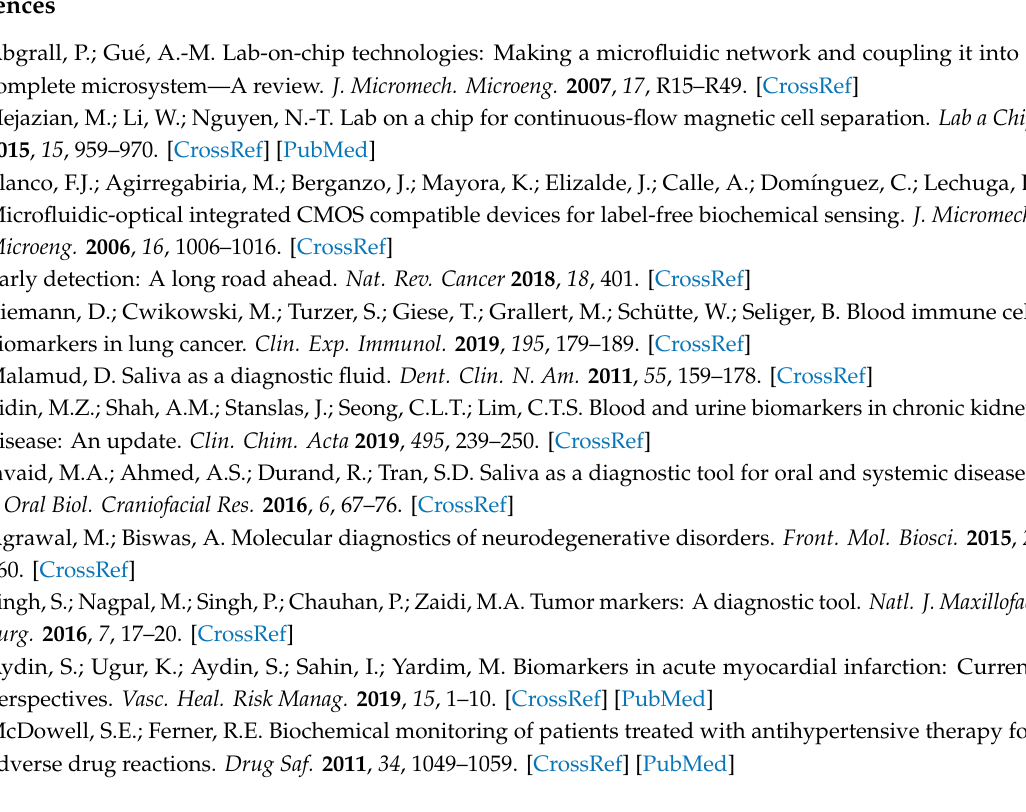
Figure S1: Soft lithography for PDMS channel fabrication, Figure S2: Dependence between injection rates of oil and water phases (QH20 / Qoil) versus the volume of generated droplets to estimate the volume of the reacting solution, Figure S3: Spectrophotometry test of the enzymatic reaction, Figure S4: Conductivity measurements of enzymatic reaction, Figure S5: The response of the FET to (a) droplets with di ff erent pH values and (b) variations in the flow rate in the presence of increasing ONPG